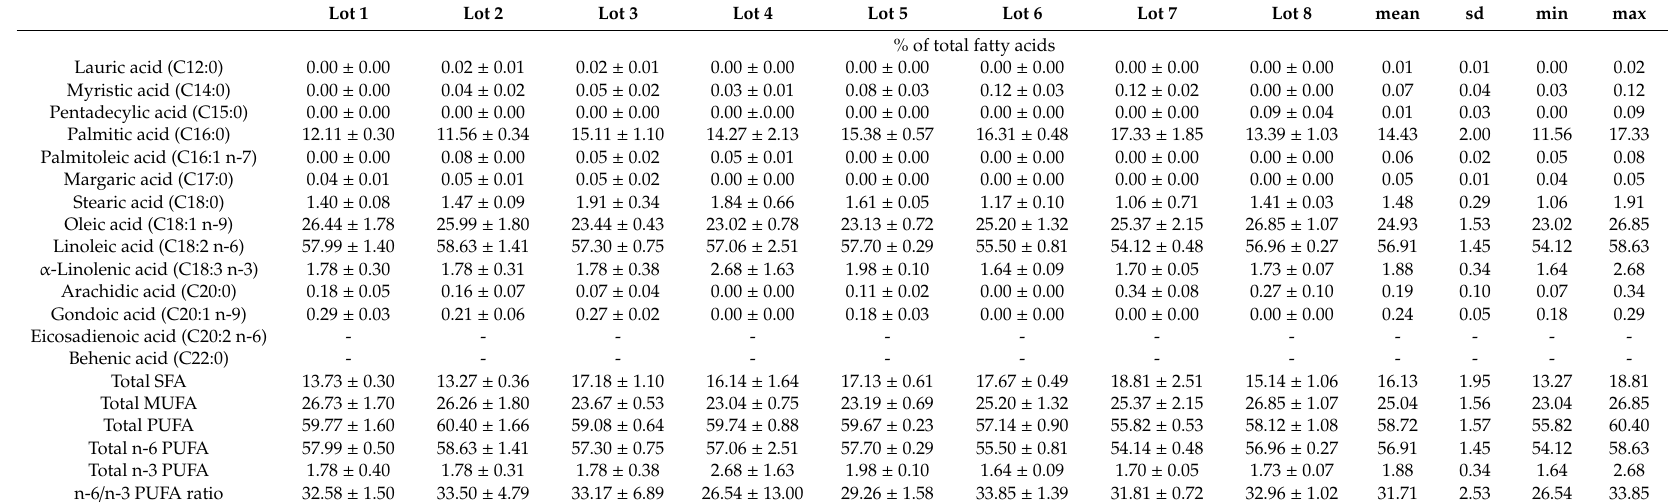
Table 2. Fatty acid profile of post-fermentation corn oil from the dry-grind corn ethanol plant. Mean, standard deviation, and range of values observed over a one-year period (n = 8) *. Values are expressed as percent of total fatty